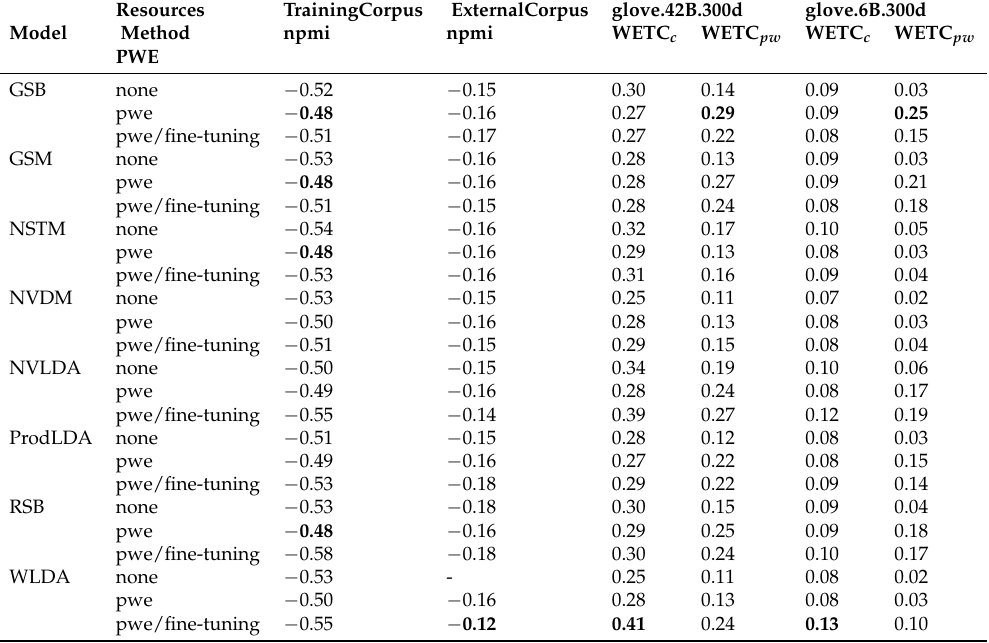
Table 7. Topic Coherence on